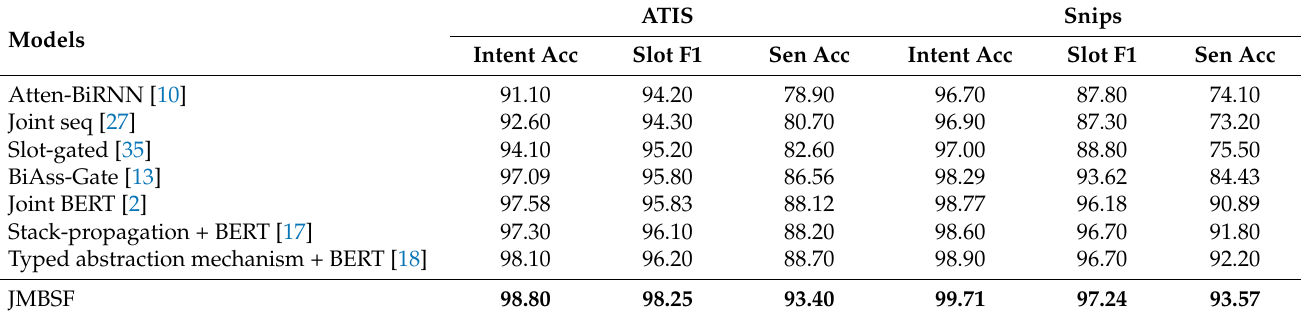
Table 3. Performance comparison of different joint models on ATIS and Snips datasets